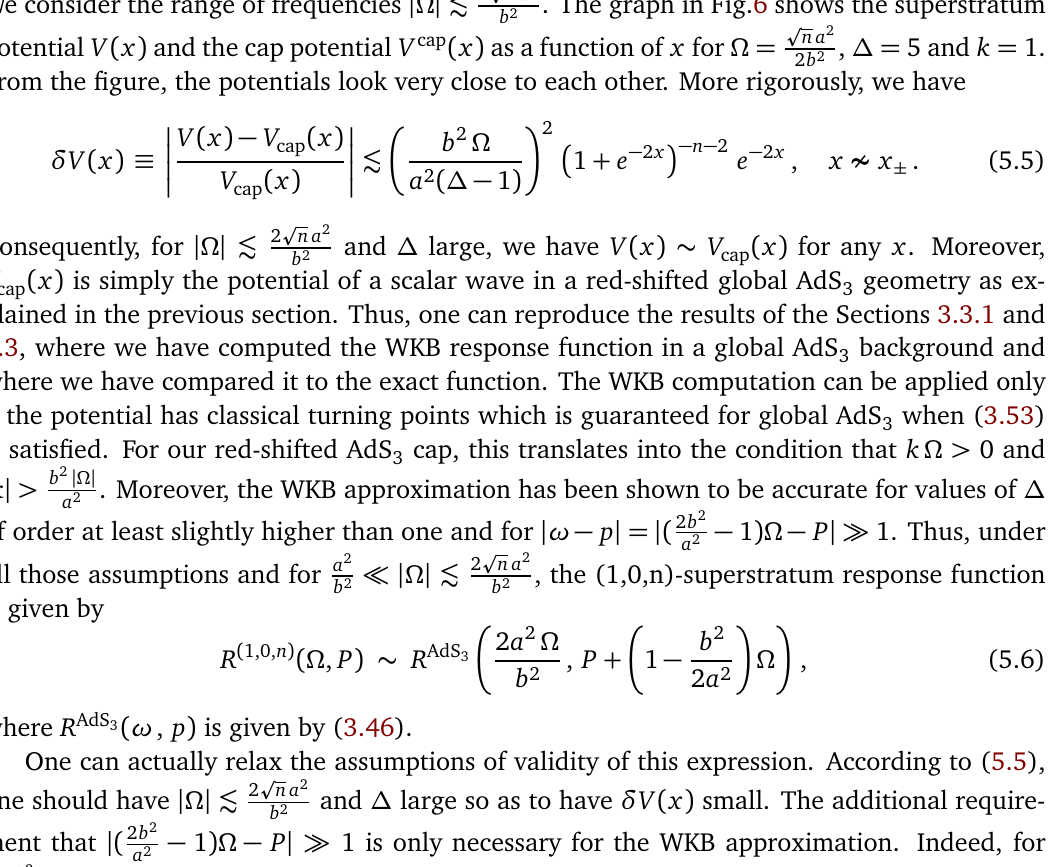
(cid:112) na 2 b 2